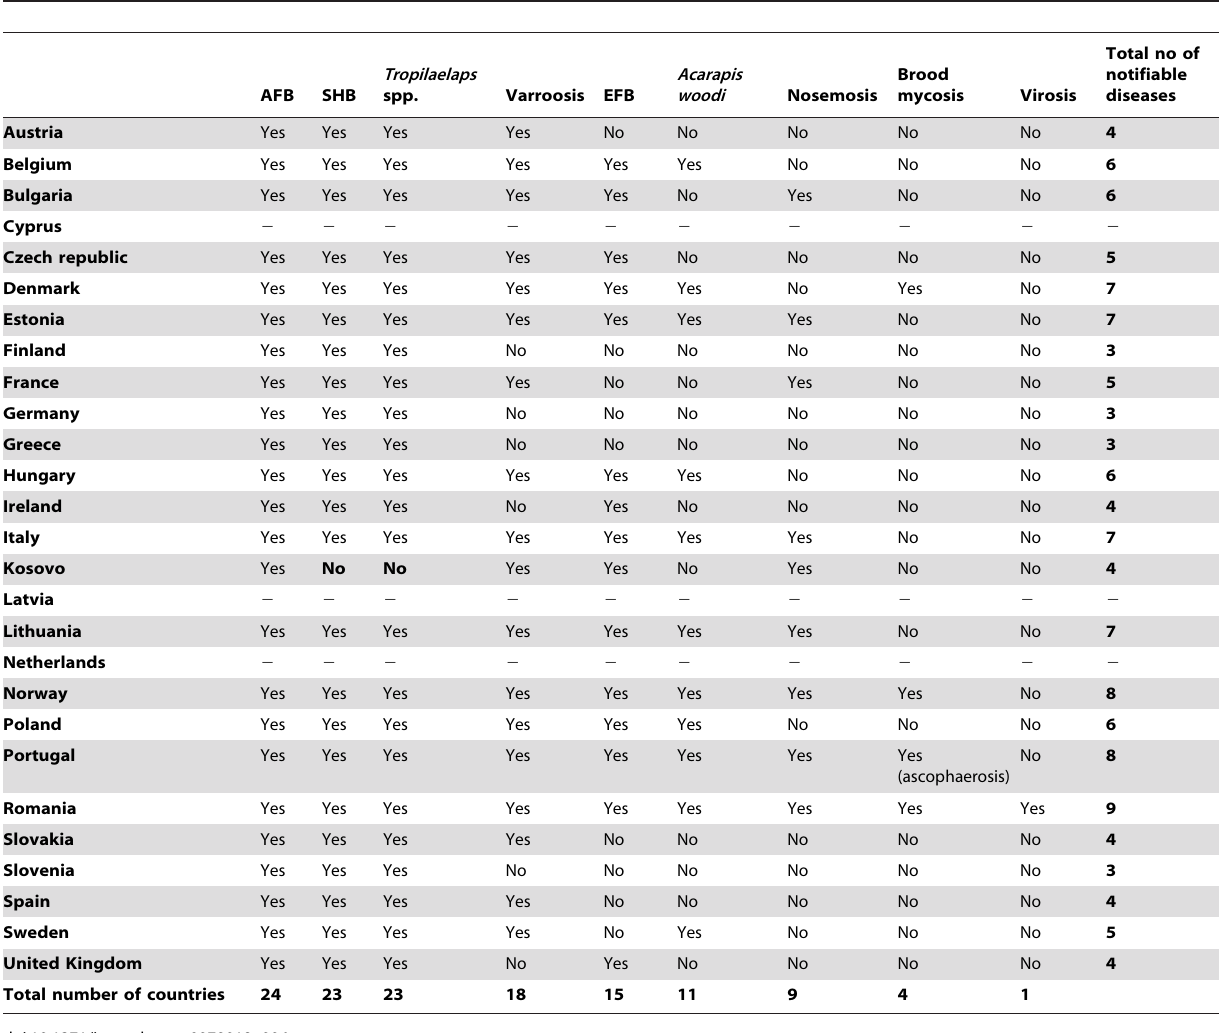
Table 6. Notifiable diseases according to national legislation of Member States in Europe in 2010.